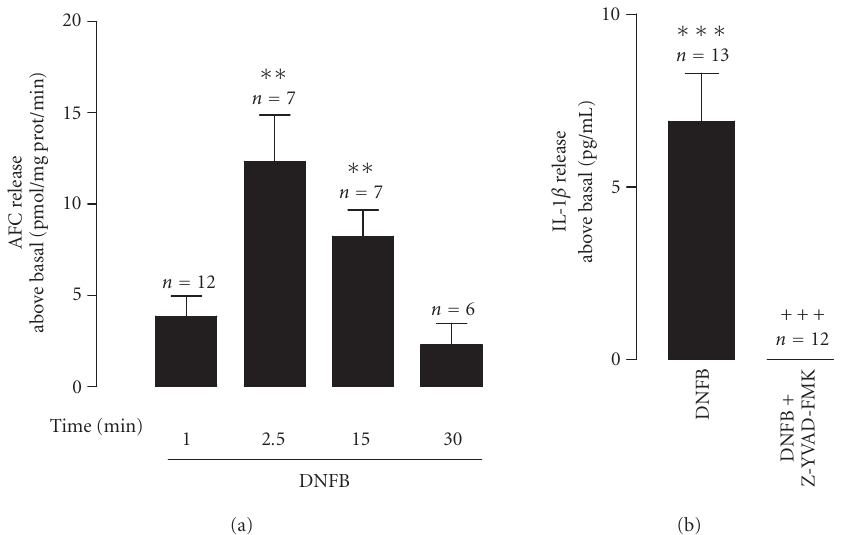
Figure 2. Interleukin-1 β -converting enzyme (ICE) protease activity and its role in DNFB-induced IL-1 β release. (a) ICE protease activity in cytosolic fractions prepared from cells incubated with DNFB (1 µ g/mL), for 1, 2.5, 15, or 30 minutes. Proteolytic activity in cell lysates was measured with the caspase-1 fluorogenic substrate Z-Tyr-Val-Ala-Asp-AFC, as described in “materials and methods.” Results are represented as AFC release above basal, in pmol/mg prot/min. Basal AFC release was 324 . 2 ± 45 . 5pmol/mg protein/min. Data express the mean ± SEM from the indicated number of experiments, performed in duplicate. Statistical significance was calcu- lated by the one-way ANOVA test with a Dunnett post-test ( ∗∗ P < . 01 as compared to the control). (b) IL-1 β concentration in the supernatants of fetal skin dendritic cell line. Cells were stimulated with 2,4-dinitrofluorobenzene (DNFB, 1 µ g/mL) in the presence or absence of the interleukin-1 β -converting enzyme inhibitor, Z-YVAD-FMK (100 µ M), for 30 minutes. In this case the cells were preincubated with Z-YVAD-FMK (100 µ M), for 90 minutes. IL-1 β was quantified with an ELISA kit. Data express the IL-1 β release above the basal secretion. Each value represents the mean ± SEM from the indicated number of experiments, performed in dupli- cate. Statistical significance was calculated by the one-way ANOVA test with a Bonferroni post-test ( ∗∗∗ P < . 001 as compared to the control; +++ P < . 001 as compared to stimulation with